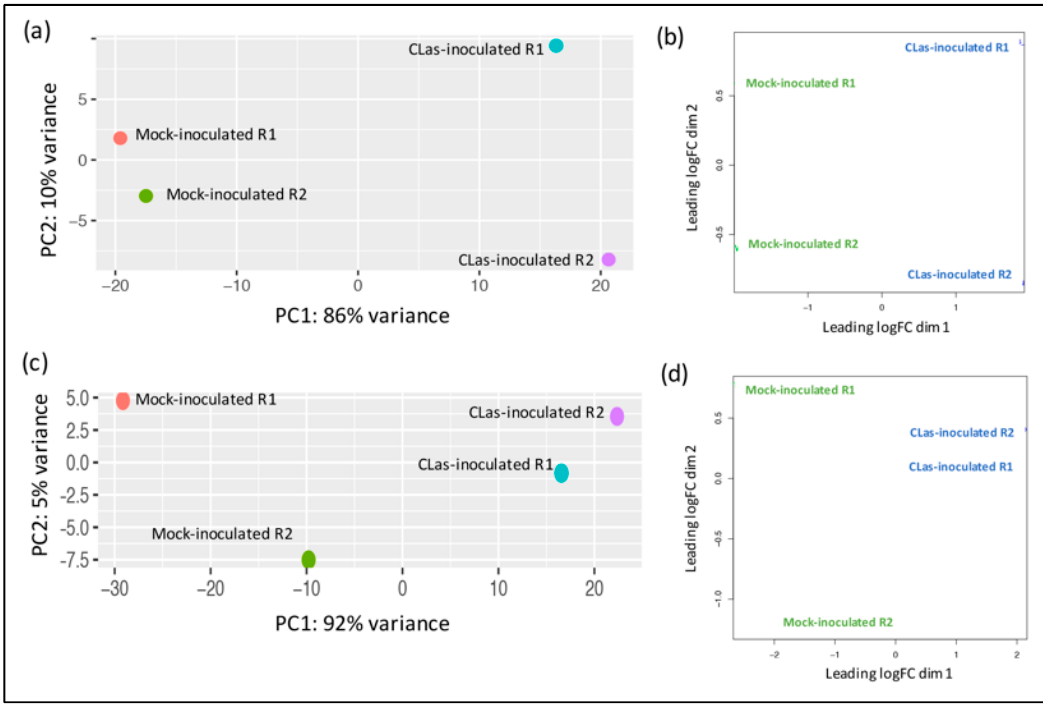
Figure 4. Principal component analysis (PCA) of gene expression from RNA-seq derived data. (a ) and ( c ): PCA performed using DESeq2 log-normalized RNA-seq data in asymptomatic and symptomatic stages, respectively. Loadings for principal components 1 (PC1) and PC2 are reported in graph (on x- and y-axes); ( b ) and ( d ): PCA performed using EdgeR log-normalized RNA-seq data in asymptomatic and symptomatic stages respectively.